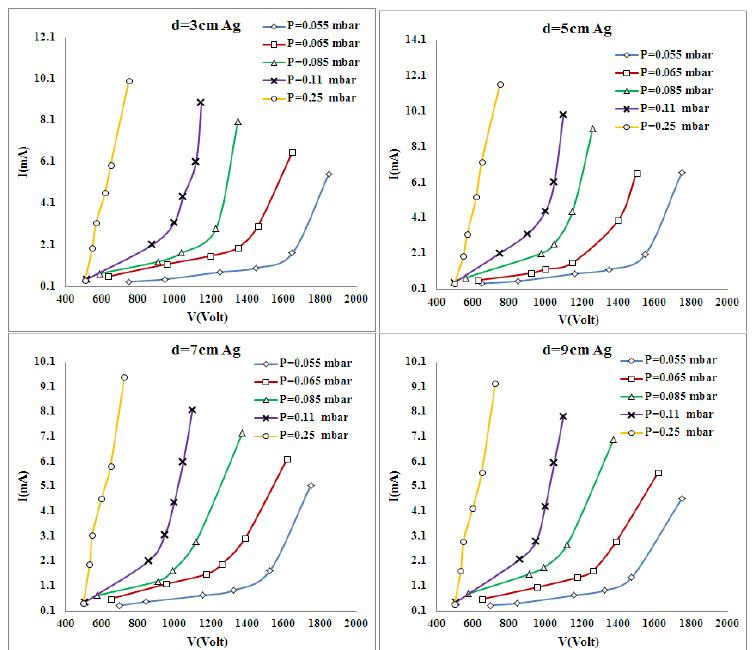
Fig. 2: The variation of discharge current as a function applied voltage at different Argon gas